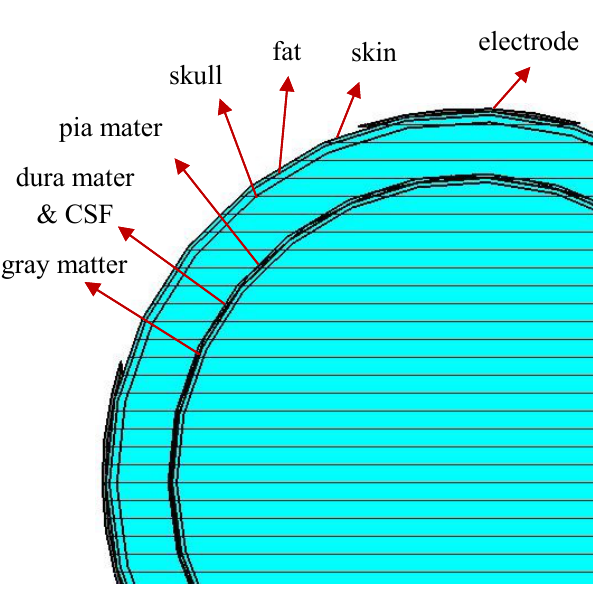
Fig. 3: The geometry of